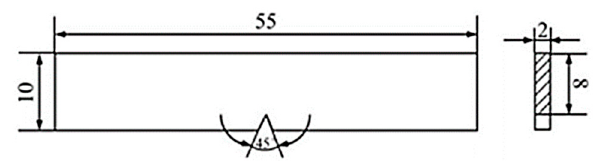
Figure 5. Schematic diagram of the impact sample size. unit: